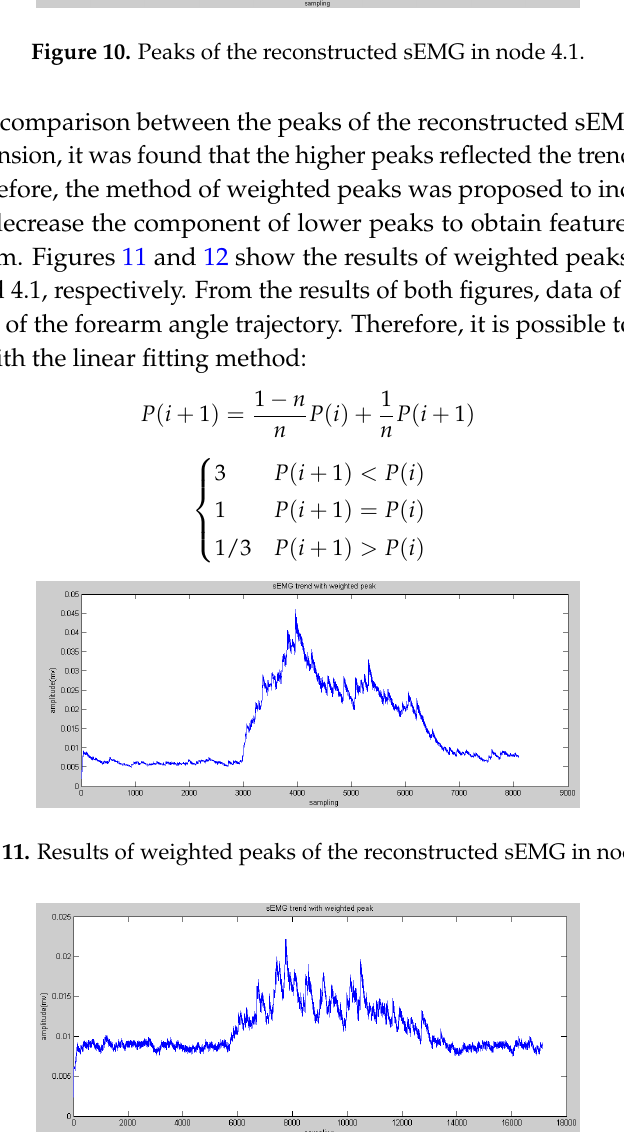
Figure 12. Trend acquisition from the reconstructed sEMG in node 4.1.